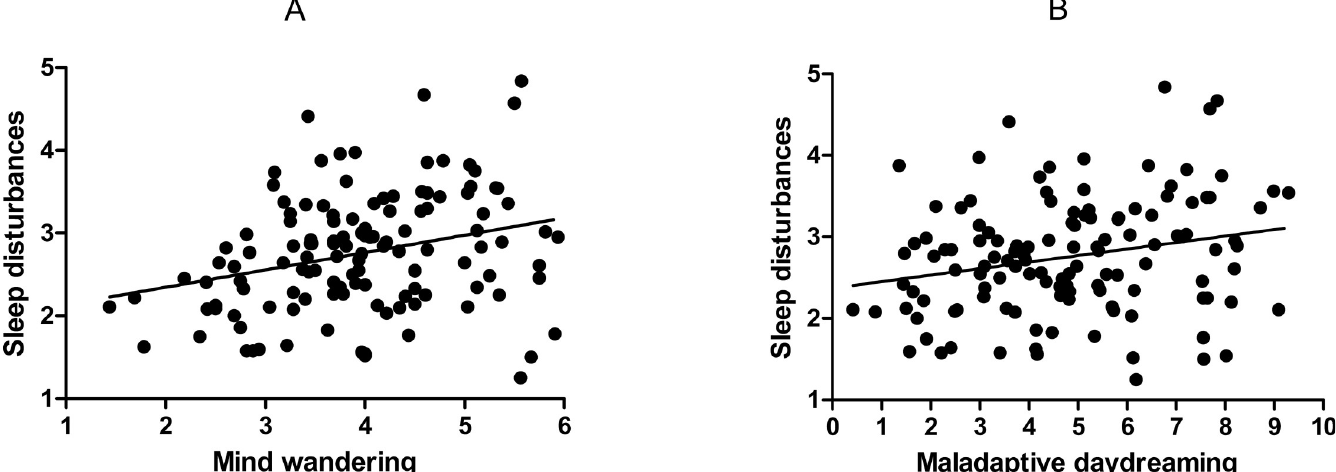
Fig 2. Scatterplots of sleep disturbances regressed on (A) mind wandering, and (B) maladaptive daydreaming. Scores are aggregated to person level so that each observation represents person mean score.